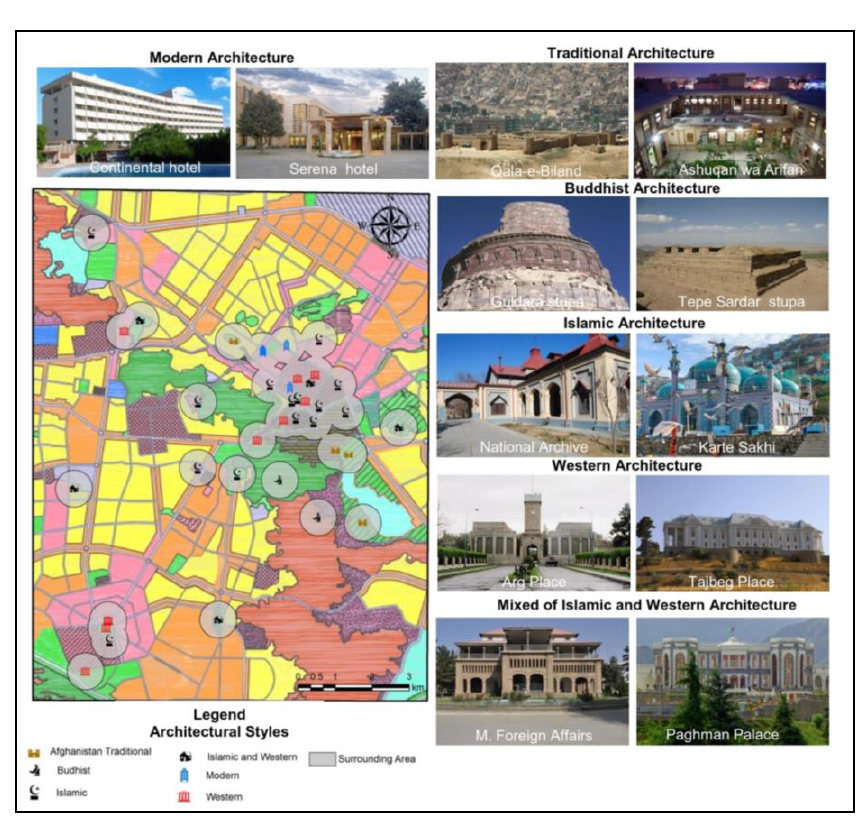
Figure 18 Spatial distribution of architectural monuments and surroundings areas in central part of Kabul city modified (KM,